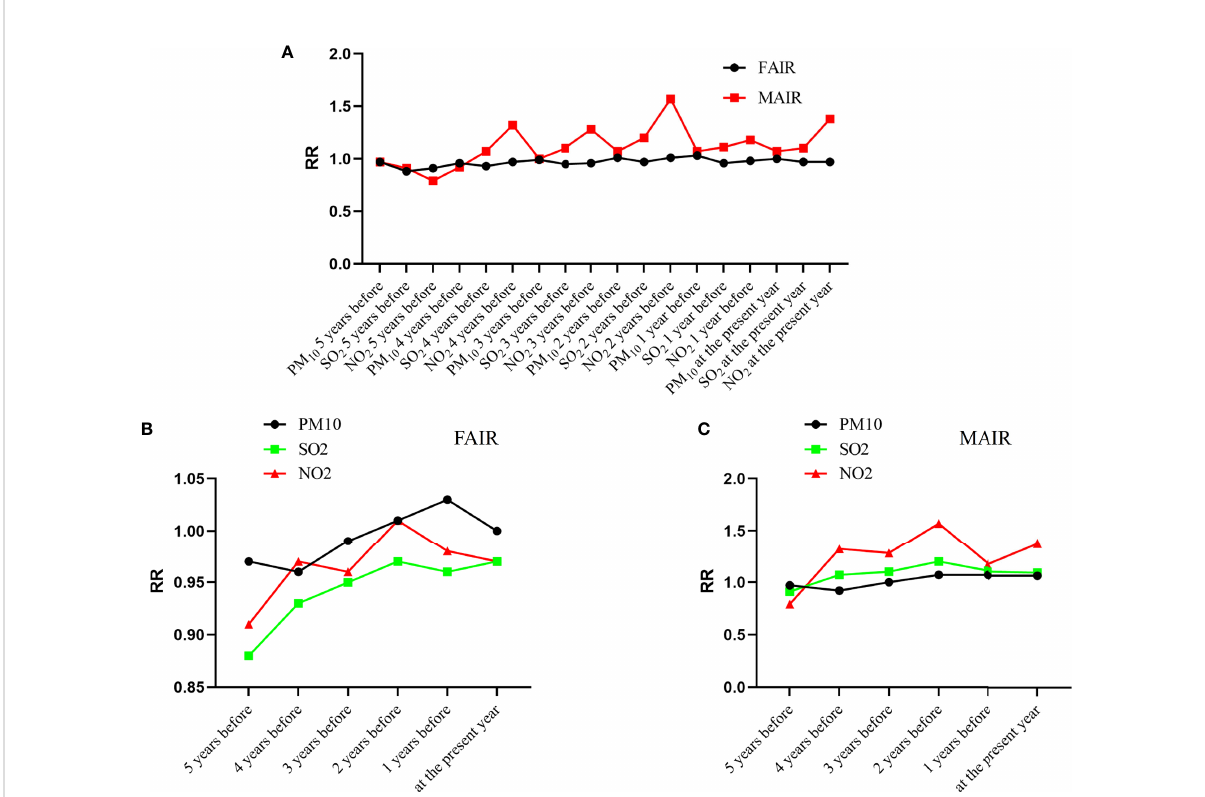
FIGURE 6 Air pollutant-related lung cancer incidence within a 5-year moving exposure window. (A) RR values of FAIR and MAIR related to the air pollutants; (B) RR values of FAIR related to individual air pollutants PM 10 , SO 2 and NO 2 ; (C) RR values of MAIR related to individual air pollutants PM 10 , SO 2 and NO 2 . RR, risk ratio; FAIR, female age-adjusted incidence rate; MAIR, male age-adjusted incidence